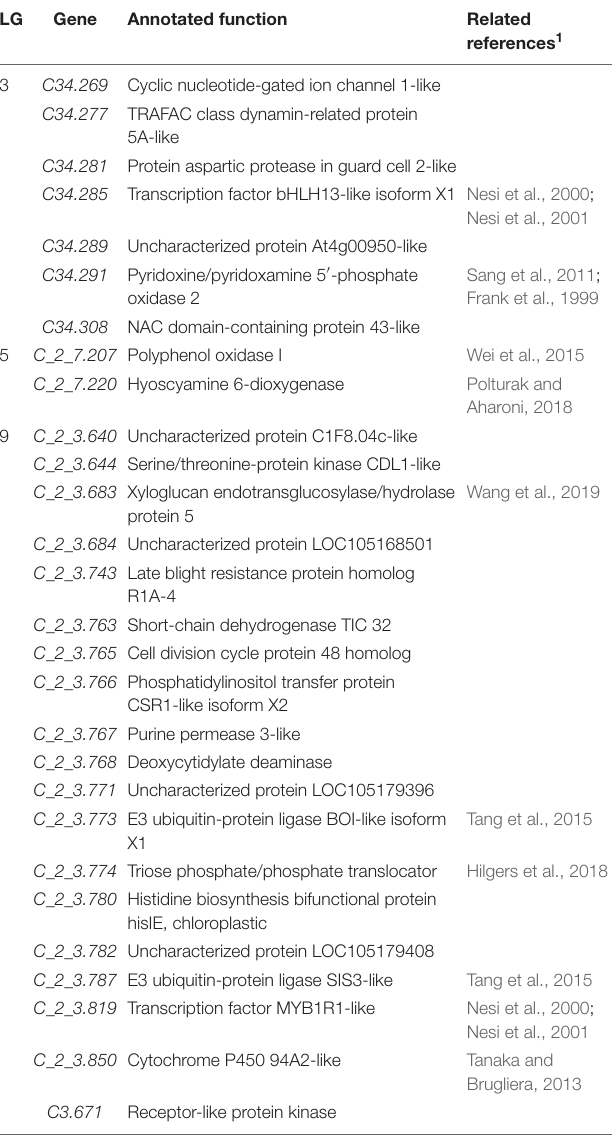
TABLE 4 | The 28 candidate genes related to seed coat color in